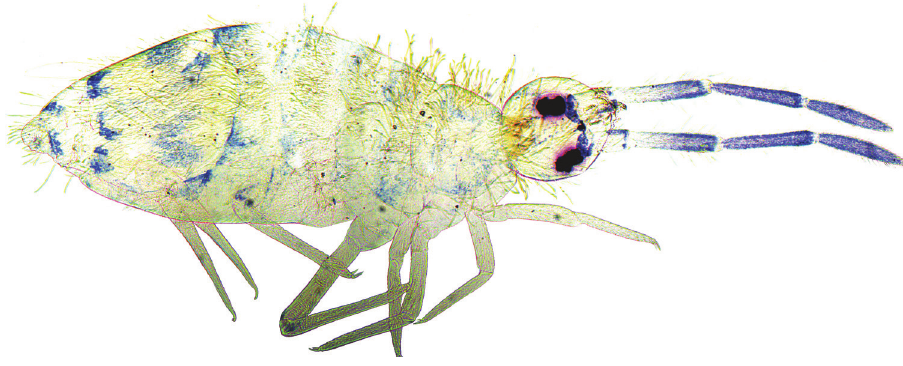
Figure 3. Entomobrya virginiae Arbea, sp. nov. Habitus.